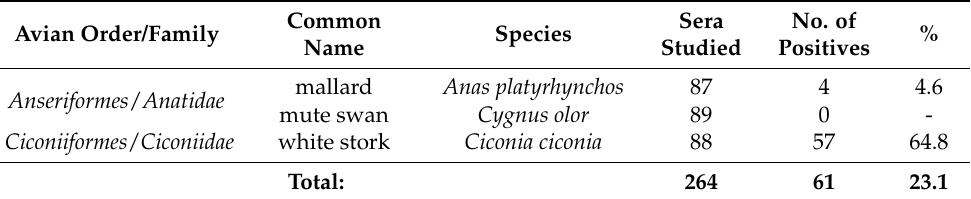
Table 2. Results of serological test (antibodies against IBV) in the tested wild bird serum. Avian Order/Family